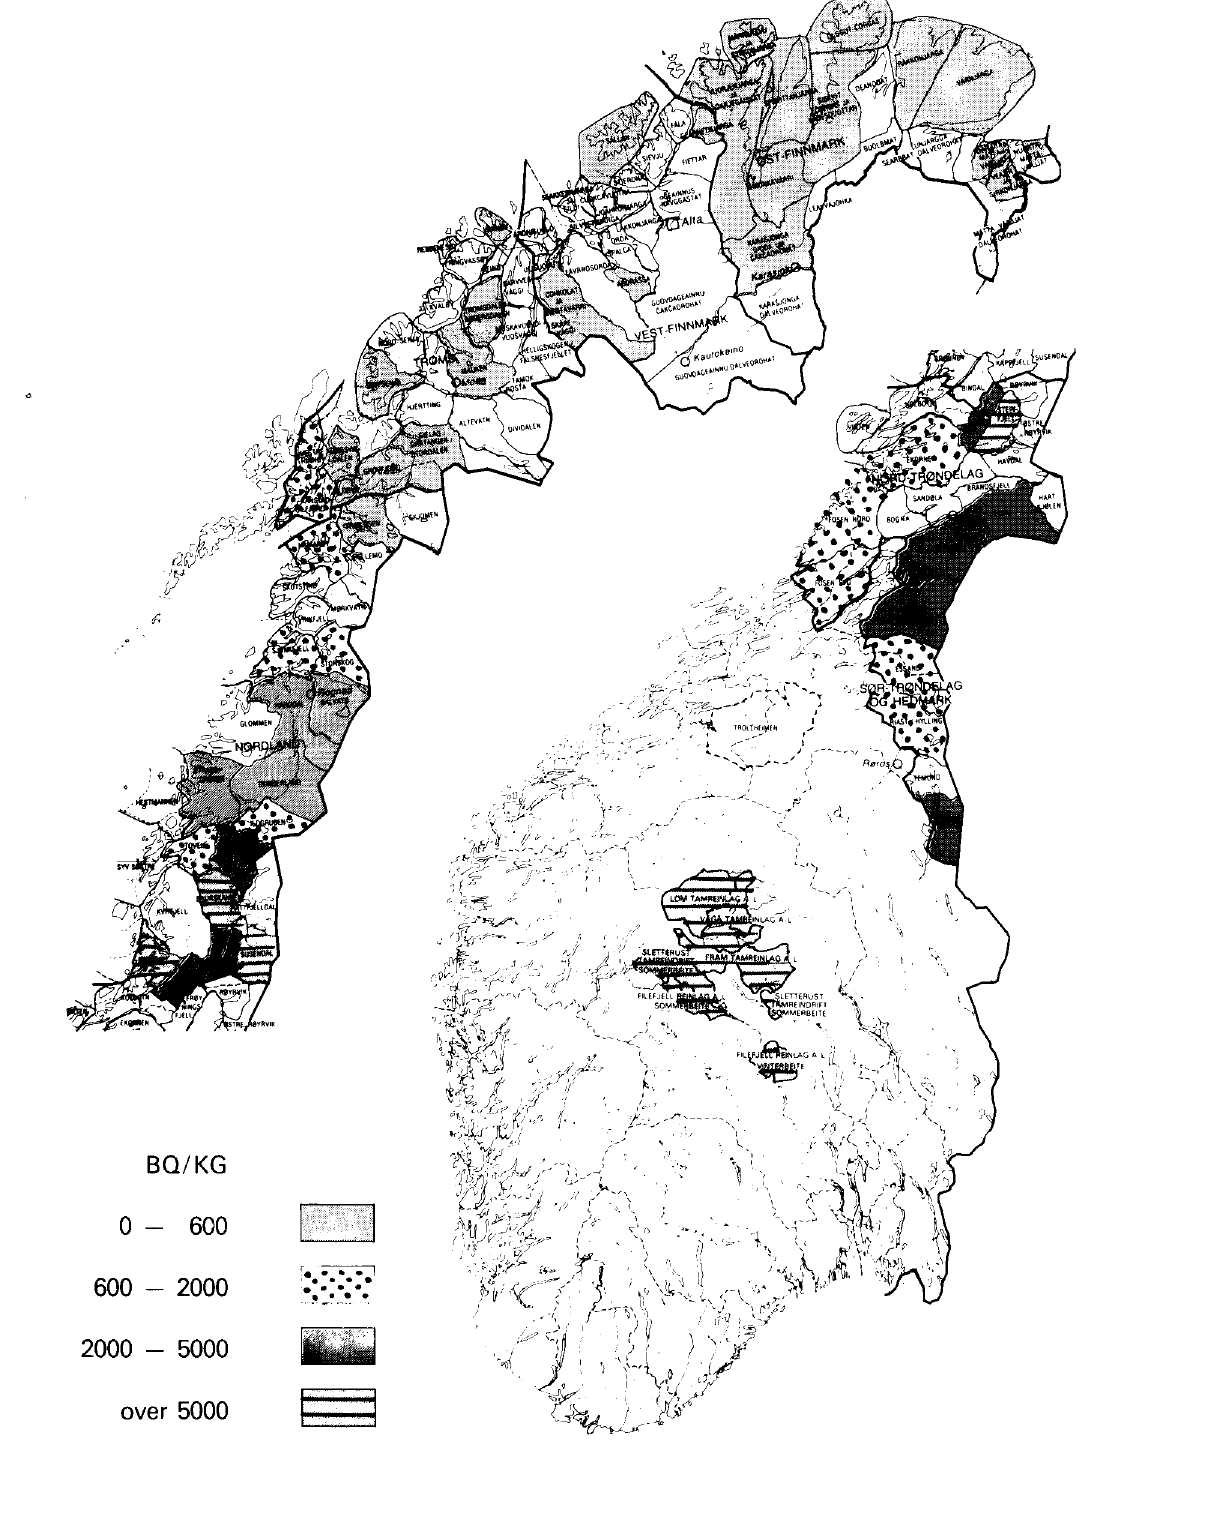
Fig. 1. Gjennomsnittlig innhold av radioaktivt cesium (137 og 134) i reinkjøtt. Prøver (165) samlet fram